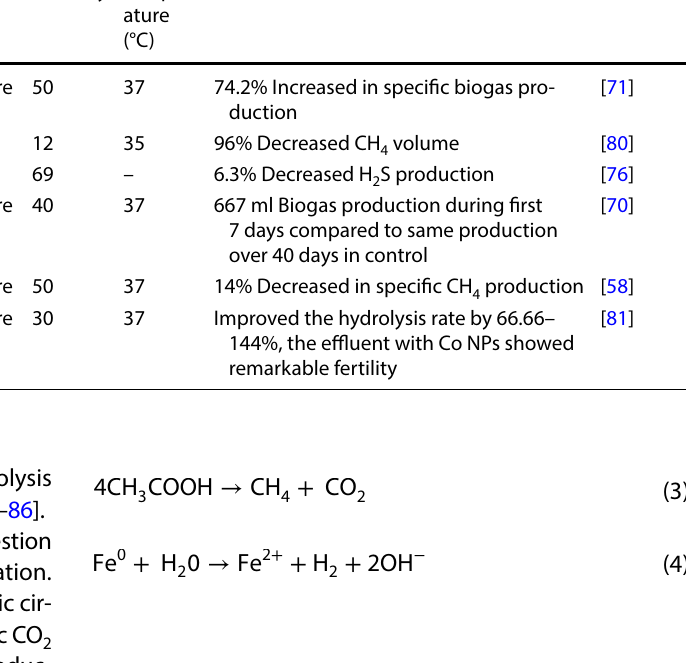
Table 3 Effects of cobalt nanoparticles on the performance of biogas production process and effluent quality NPs type NPs Size, nm Concentrations of NPs Substrate type HRT, day Temper-